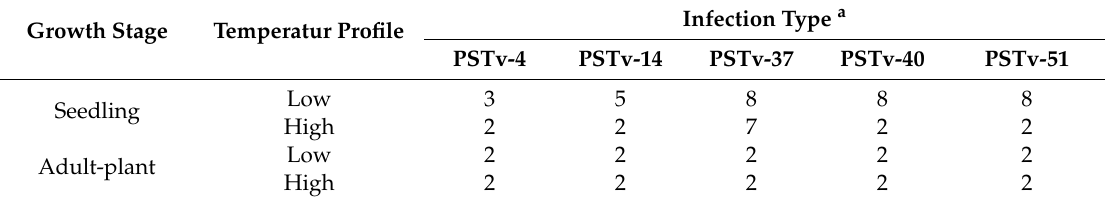
Table 1. Stripe rust infection types of PI 181410 to five predominant or most virulent races of Puccinia striiformis f. sp. tritici in the United States tested in seedling and adult-plant stages at low (4–20 ◦ C) and high (10–30 ◦ C) temperature profiles.